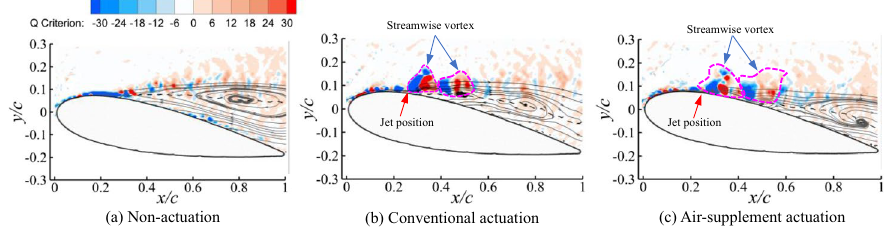
Fig. 18 Vortex contour and streamlines in different actuation states at α